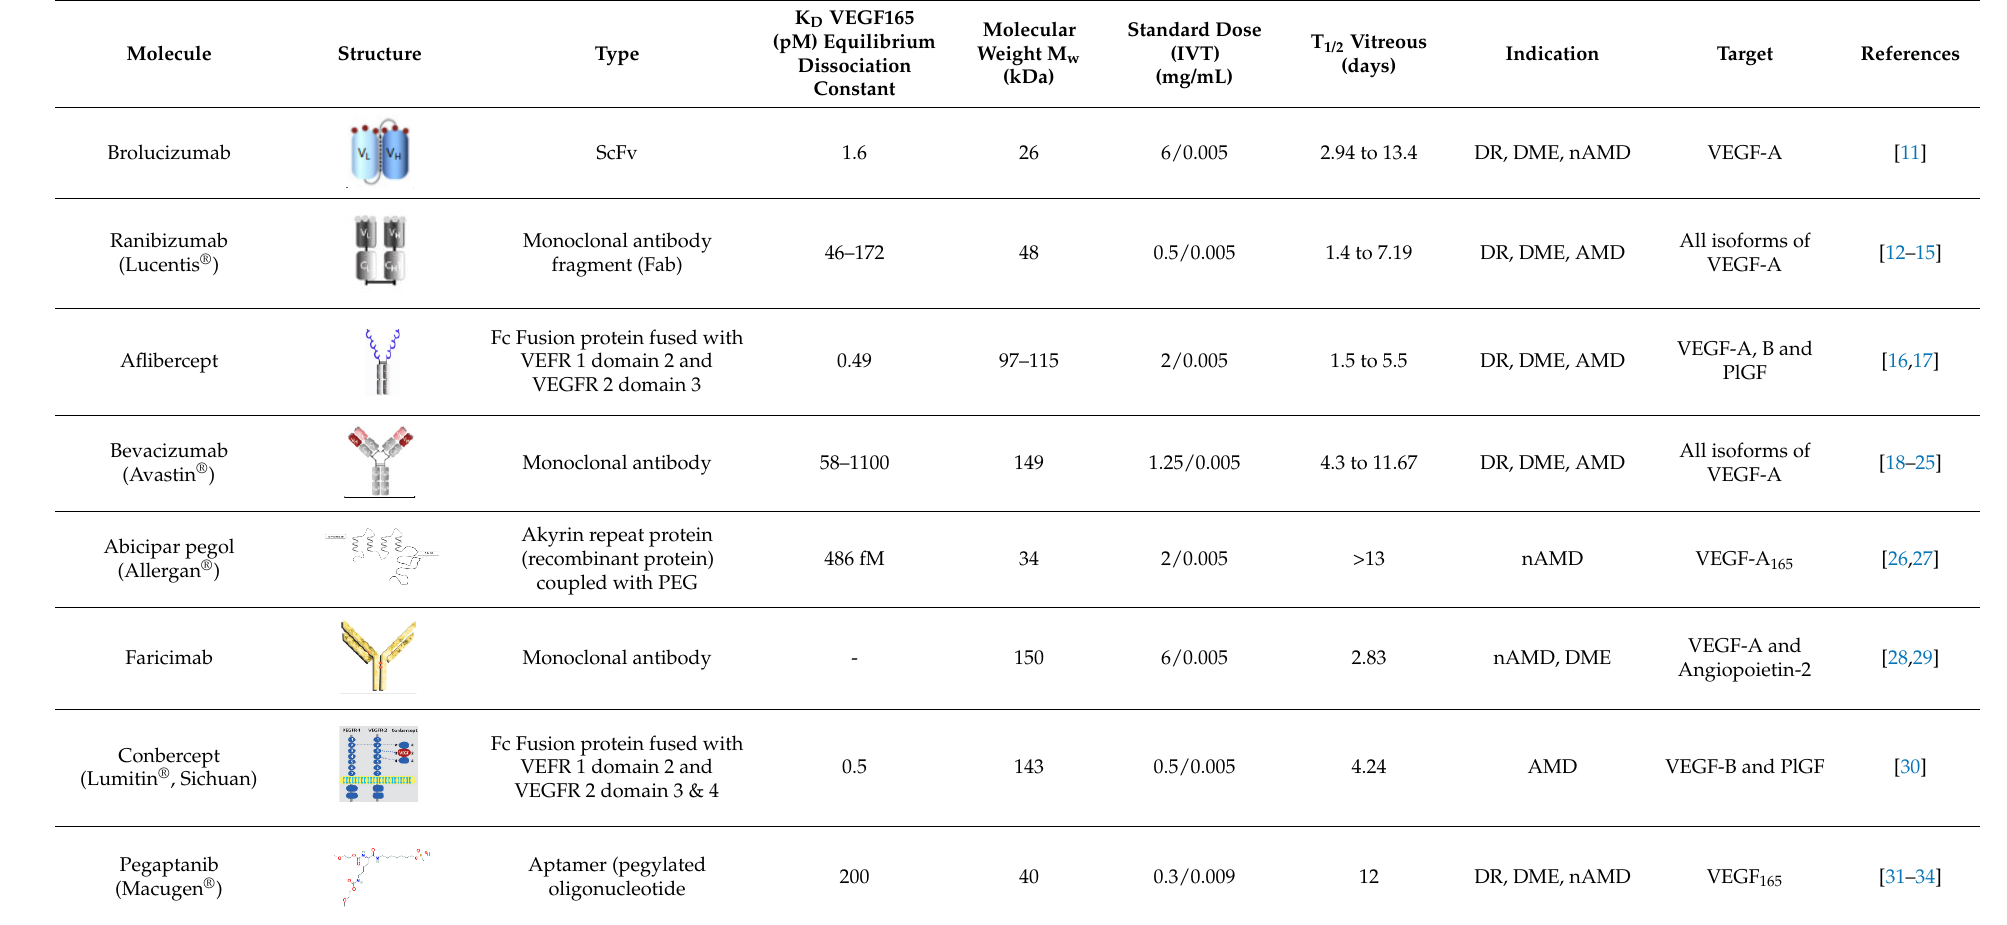
Table 1. Molecular characteristics of various antivascular endothelial growth factor (VEGF) antibodies and anti-VEGF agents.